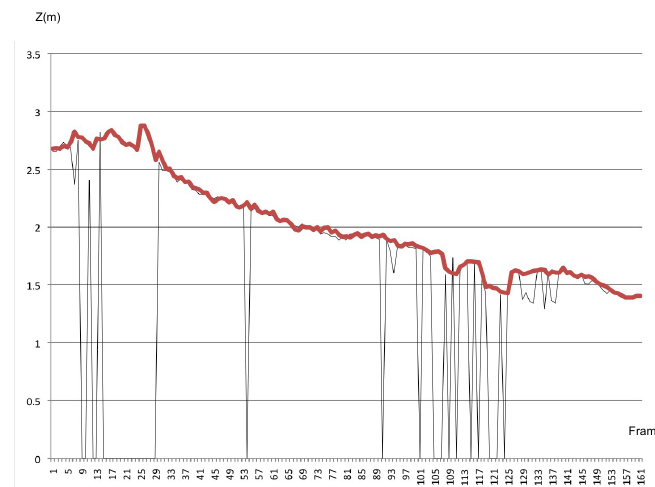
Figure 34. Occlusion zone: this graph is a detail of the graph of the Figure 32, from the frame 124 to frame 284, here we can compare the estimation in the temporary occlusions zone with and without the use of the filter. The black curve is the estimation without filter and the red curve is the estimation with filter. The frame 124 was renumbered with the number 1.